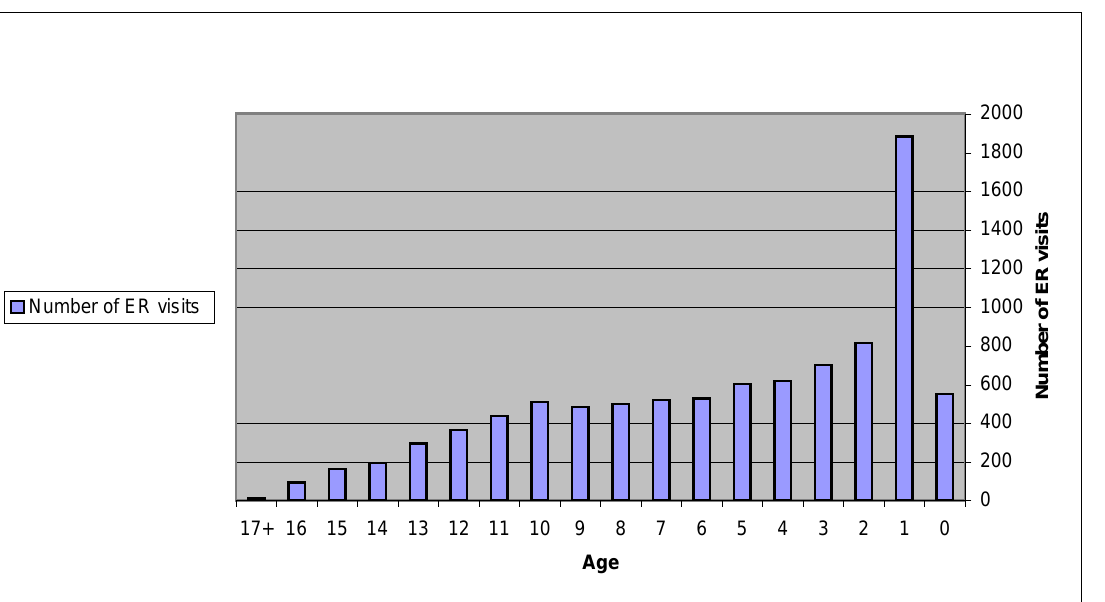
FIGURE 1 . Number of emergency room visits in 1996 due to injury, by